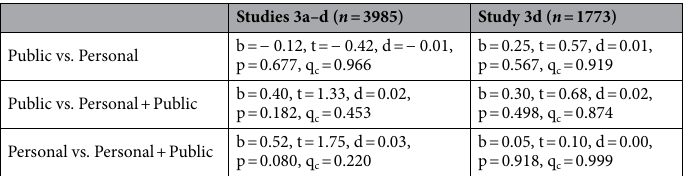
Table 5. Comparisons between treatments in Study 3. For each pairwise comparison, we report the relative effect of the treatment listed first on Time 2 prevention intentions, when controlling for Time 1 prevention intentions (across Studies 3a–d, and in Study 3d only).